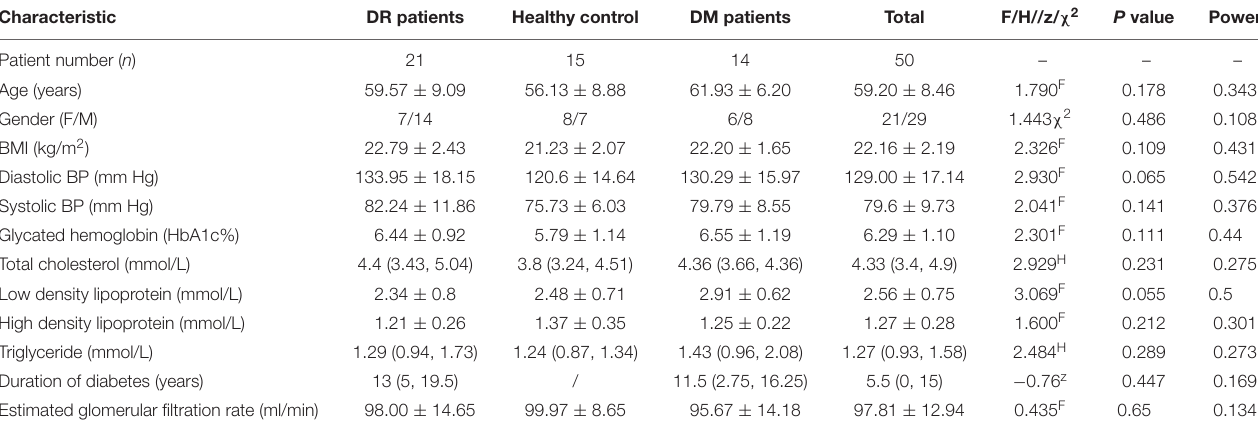
TABLE 1 | Demographic and clinical characteristics of DR patients, DM patients, and healthy